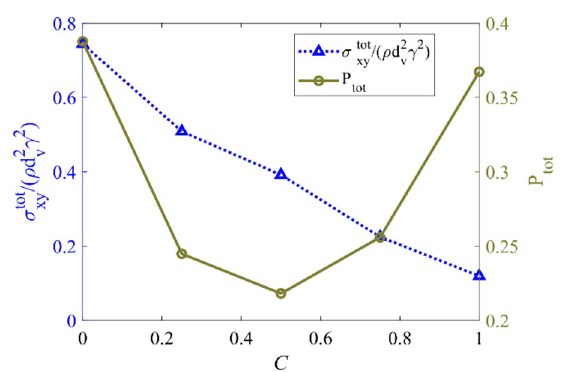
Figure 9. Variation of the average normalized shear stress and the overall fraction of stacking particles P tot with the rods fraction C for binary mixtures of AR = 0.3 and AR = 6. The solid volume fraction is ν = 0.5.